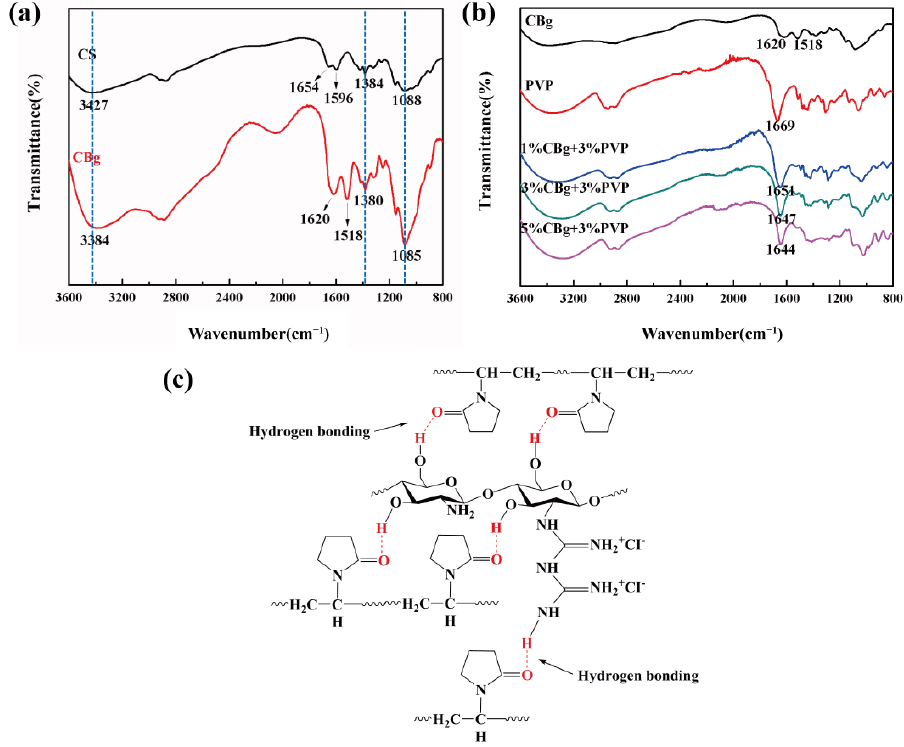
Figure 1. ( a ) FTIR spectra of CS and its derivative CBg. ( b ) FTIR spectra of CBg, PVP, and CBg/PVP films with different mass concentrations. ( c ) Schematic diagram of the interaction between CBg and PVP.